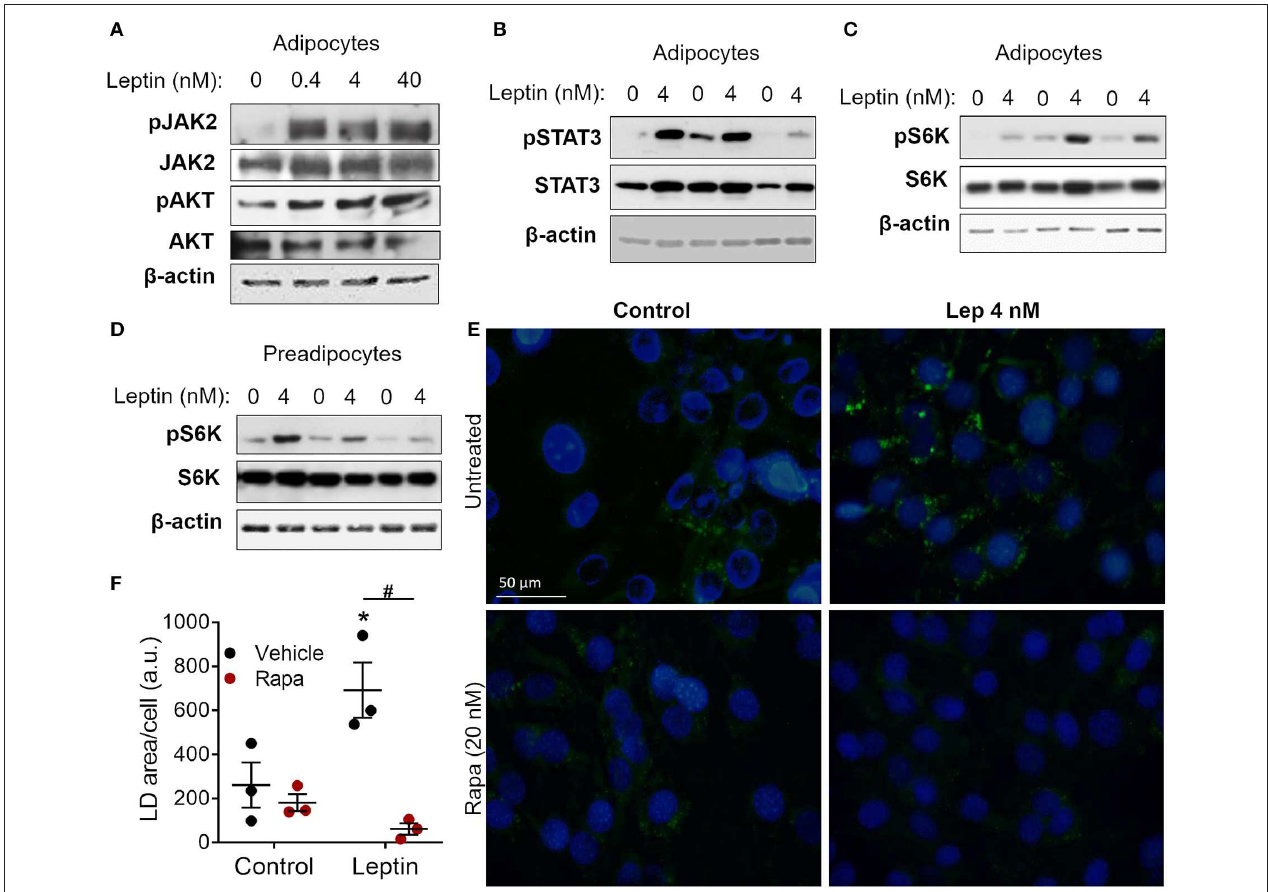
FIGURE 2 | Leptin-induced adipogenesis depends on mTOR/p70 S6K pathway. (A–D) 3T3-L1 cells were cultured as described in methods up to day − 1 (preadipocytes) and day 17 (adipocytes) and then stimulated with leptin at the indicated concentrations for 20min. (A) Western blot analysis of phosphorylated JAK2 (pJAK2), total JAK2, pAKT, total AKT, and β -actin. Blots are representative of three independent experiments. (B) Western blot analysis of pSTAT3, total STAT3, and β -actin in adipocytes from three independent experiments analyzed in the same gel. (C,D) Western blot analysis of pS6K, total S6K, and β -actin in adipocytes (C) and preadipocytes (D) from three independent experiments. (E,F) Preadipocytes were cultured for 48h with no stimulus (control), leptin (4nM), rapamycin (20nM), or both. Cells were stained with Bodipy (green) for lipid droplets and with DAPI (blue) for nuclei. (E) Shows images representative of three independent experiments. Scale bar represents 50 µ m in range. (F) Quantification of the green area per cell in each condition. Dots represent the replicates of one experiment representative of three. Horizontal lines represent mean ± standard error of the mean. *Means p < 0.05 relative to control, # means p < 0.05 between vehicle and rapamycin treated cells. Statistical analyzes were performed by using Two-way ANOVA with Sidak’s